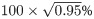
Body Temperature curves.Temperature COSINOR curves (blue) and smoothed curves by local polynomial regression (function “LOESS” in red) for Patients (upper pattern) and Control group (lower pattern). The solid blue lines corresponds to results from the estimated cosinor function The dashed lines around the solid line correspond to a confidence band of level
100×0.95%
for the estimated cosinor curve. Solid red lines result from local polynomial regression (with span parameter α = 0.25). As before, dashed red lines correspond to the borders of the confidence band of level
100×0.95%. Thus, areas in which the two confidence bands do not overlap indicate a difference between the two functions with confidence level 95%. The highest and lowest values estimated by the LOESS method are respectively observed at 4:29 PM and 7:40 AM (although a nearly equally low minimum is already attained much earlier in the morning). The deviations were marginal since the local smoother mostly overlaps the COSINOR modeling only around 5:00 AM and 8:00 AM and around 4:00 PM and 7:00 PM. More precisely, the local smoother indicates that the temperature remains at a lower level than the COSINOR in the morning, with the largest difference attained at about 6:30 AM. In the following hours, the temperature rises faster than the COSINOR captures, and attains its steady state about 12:40 PM. In the following hours, the temperature remains relatively stable at a high level, roughly between 37.25 and 37.35°C. Then, in the evening at about 9:10 PM, the temperature drops, and the decline is stronger than the COSINOR is able to capture.